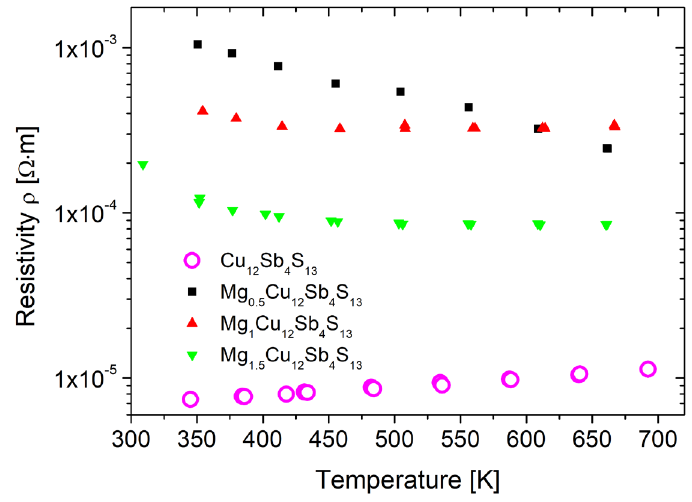
Figure 13. Temperature dependence of electrical resistivity for Mg x Cu 12 Sb 4 S 13 sintered samples.